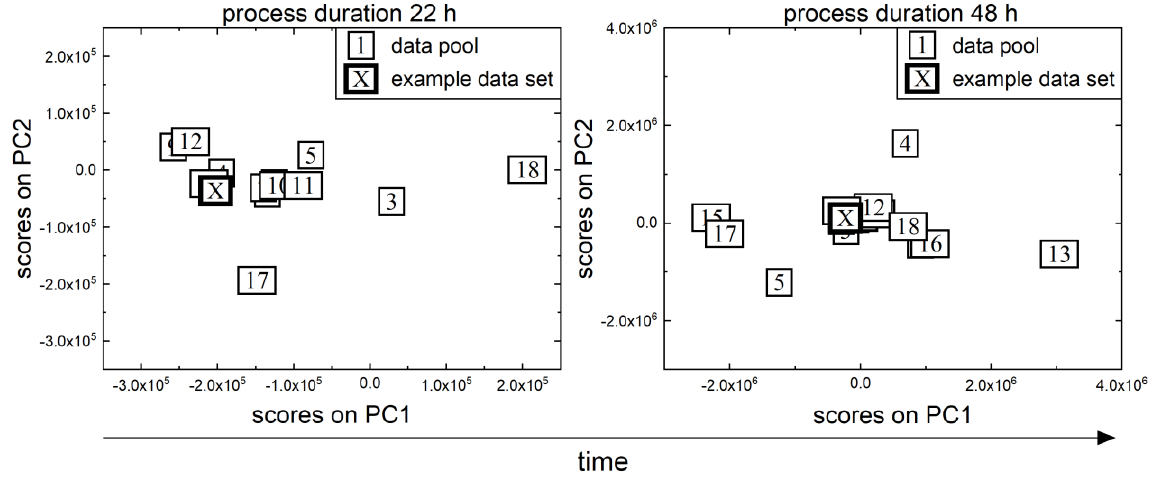
Figure 4. The MPCA of the P. pastoris data pool at two different time points is depicted (22 and 48 h). Each box represents a different data set; the number indicates the batch number. The results of the first two principal components of the data pool (thin frame) and the example data set are shown (thick frame). PC = principal component.